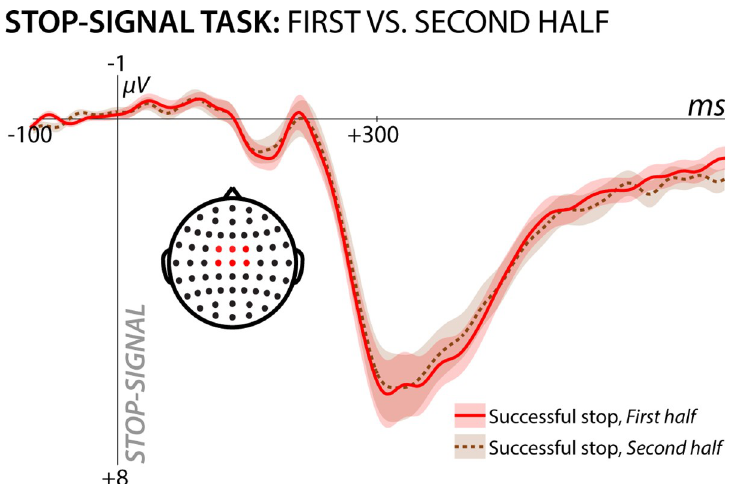
Fig 10. Stop-signal P3 split by phase of the SST experiment. If the process underlying the stop-signal P3 was stop- signal-induced surprise, its amplitude should decrease in the second half of the experiment. Instead, the stop-signal P3 is nearly identical across the two halves of the experiment. Shaded area around the ERP curves denotes the standard error of the mean.